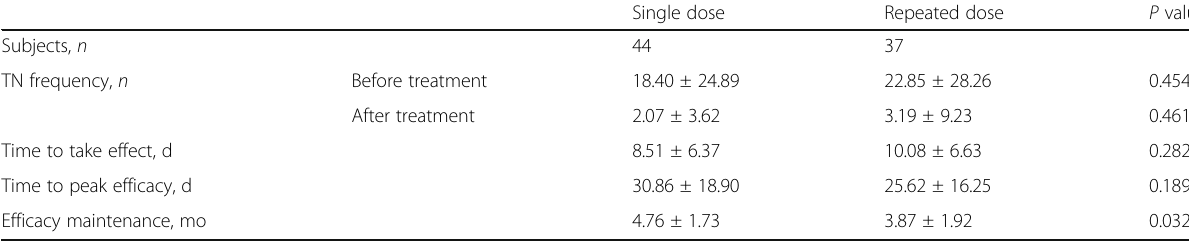
Table 2 Evaluation on the efficacy of single and repeated doses of BTX-A